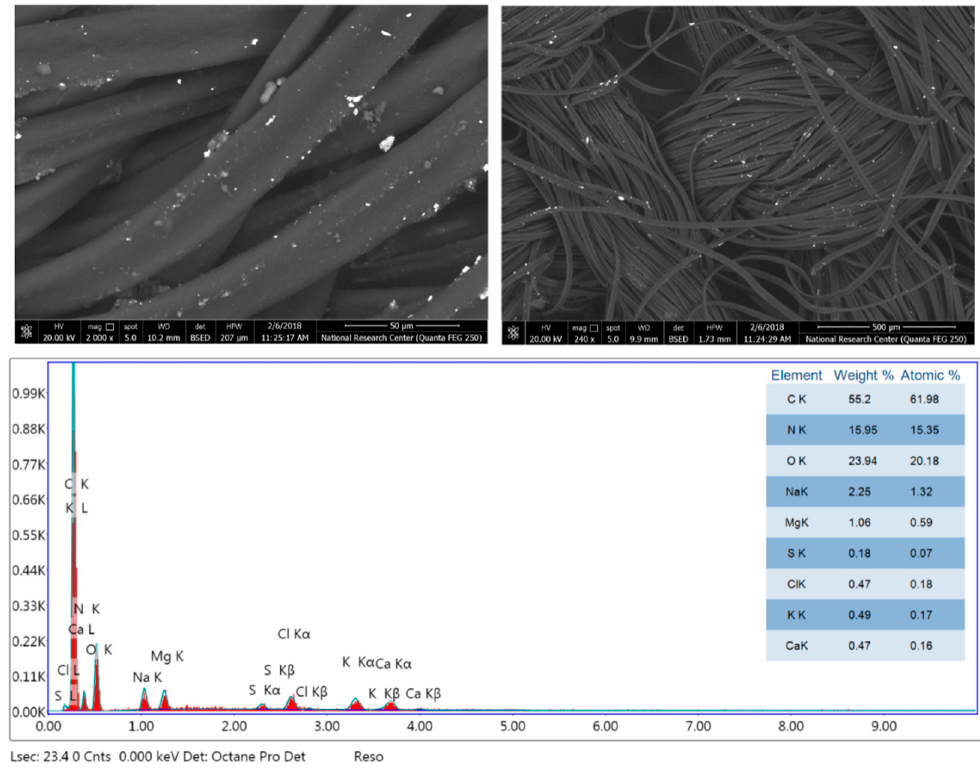
Figure 9. SEM images and EDX diagram of MgO nanoparticles deposited onto a post-treated acrylic fabric screen-printed with C.I. Basic Yellow 28.